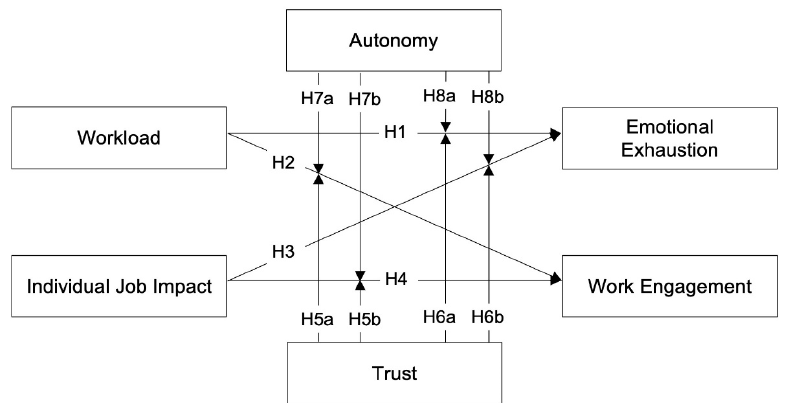
Figure 1. Conceptual Research Model.